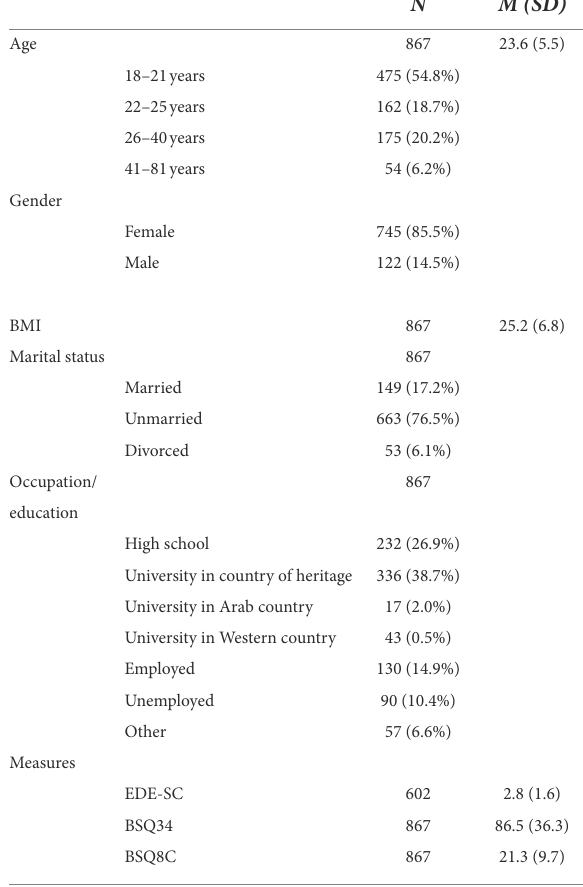
TABLE 1 Demographics of a Saudi convenience sample ( N =